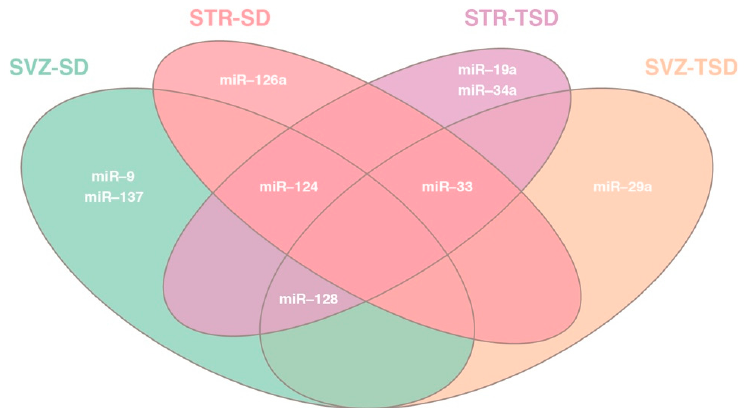
Figure 3. Venn diagram of differentially expressed miRNAs analysis in SVZ and STR of SD and TSD mice. Shown are miRNAs shared between both brain areas in SVZ and STR of both GM2 gangliosidosis mice, and miRNA(s) that is/are characteristic of one brain region only.